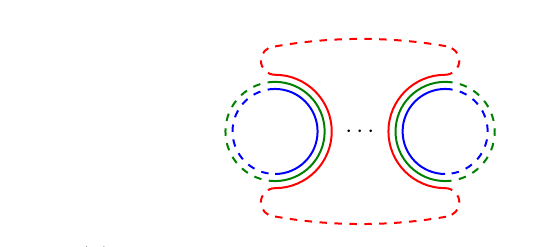
(b) Broken ladder diagram in Pillow channel (cid:24) N 2 . Figure 18. Unbroken and broken ladder diagram contribution of order O ( N 2 ). The dashed line represents contraction of external gauge